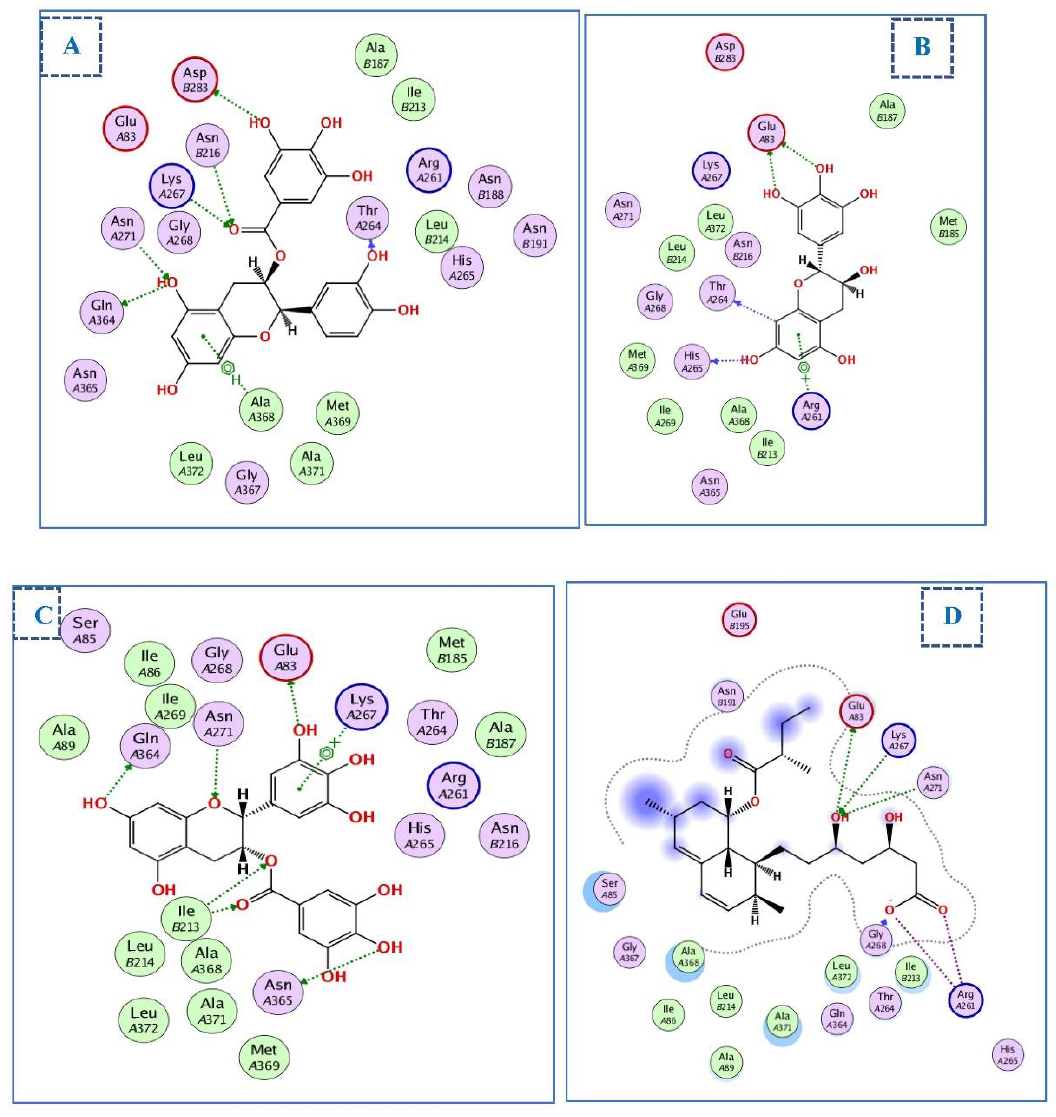
Figure 7. Two-dimensional diagram of ( A ) (-)-epicatechin gallate, ( B ) (+)-gallocatechin, ( C ) epigal- locatechin, and ( D ) LVA into the binding site of HMG-CoA reductase (PDBID: